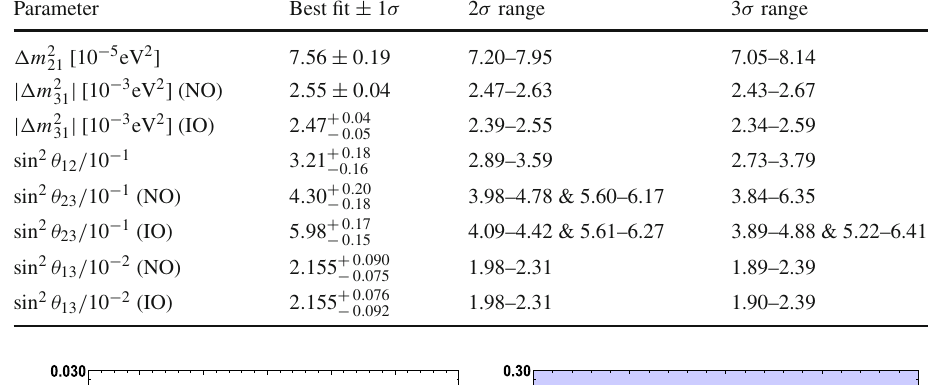
Fig. 2 The left panel shows the dependence of the reactor mixing angle θ 13 on λ 1 and right panel represents the correlation between the sum of total active neutrino masses and λ 3